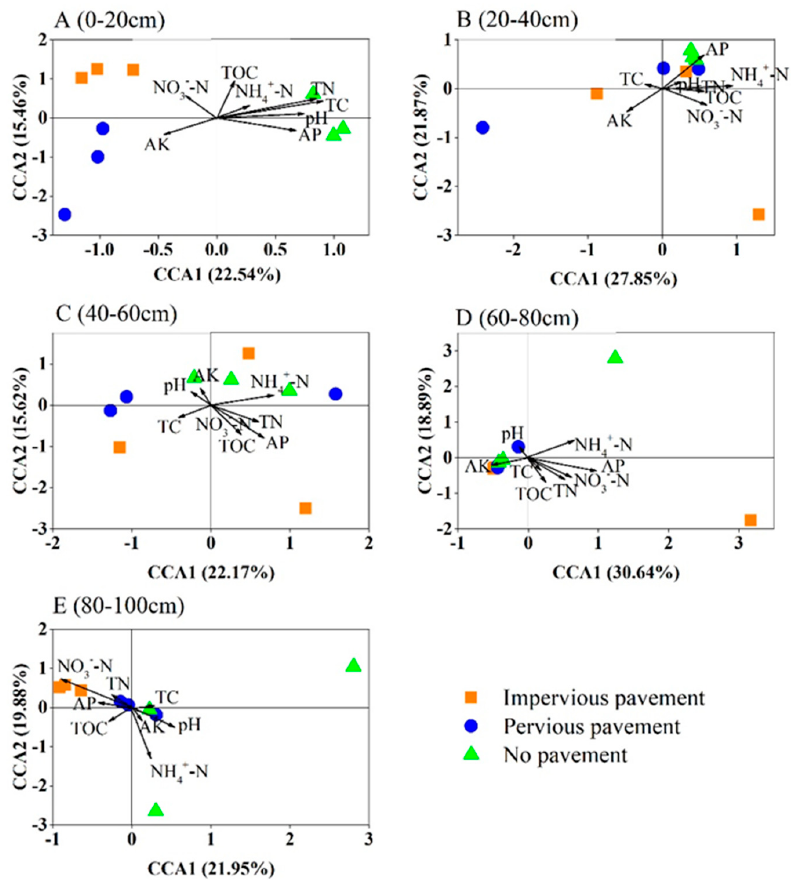
Figure 4. Canonical correspondence analysis (CCA) of the bacterial communities with symbols coded by pavement type under different soil depths. ( A ) 0–20 cm; ( B ) 20–40 cm; ( C ) 40–60 cm; ( D ) 60–80 cm; ( E ) 80–100